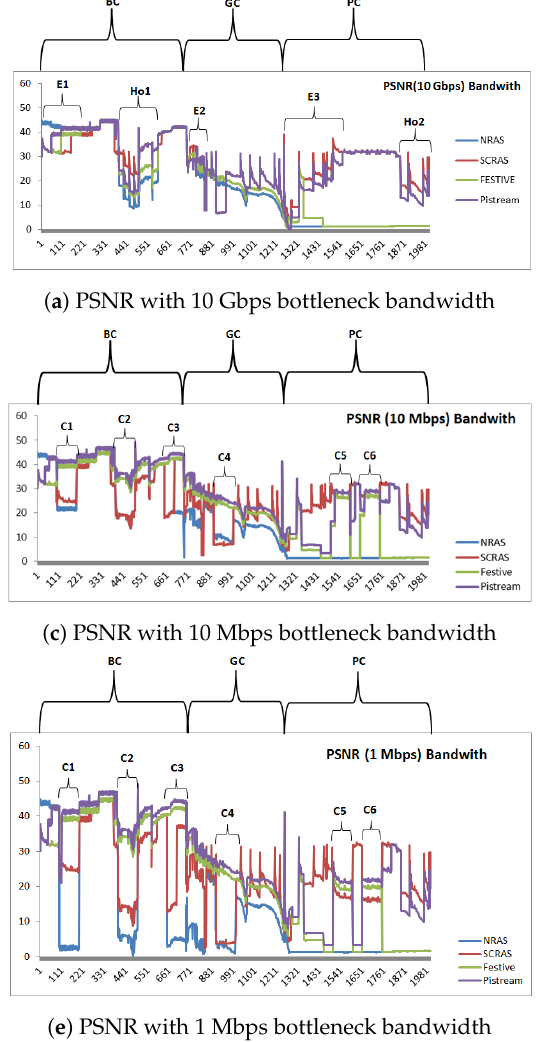
Figure 9. Impact of congestion in the core